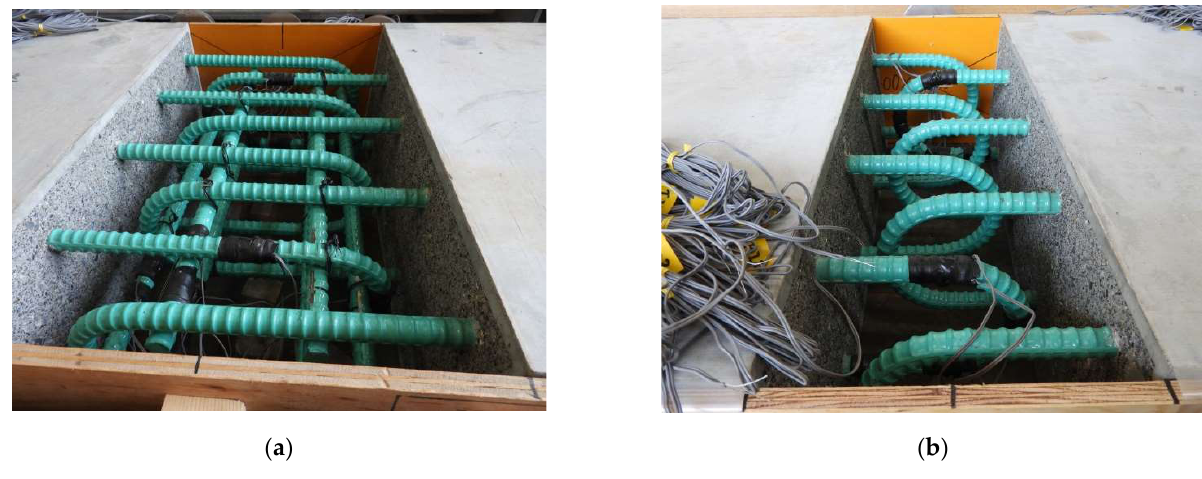
Figure 6. Joints before casting joint materials: ( a ) Type A; ( b ) Type B.